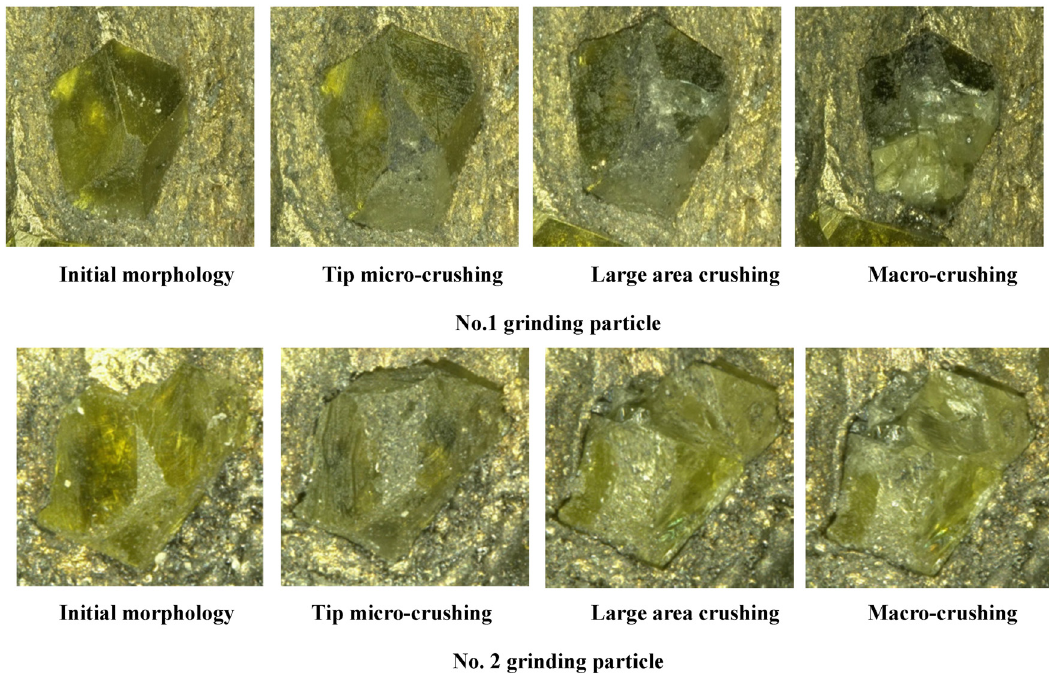
Figure 5: The morphology of the fi rst group of abrasive particles. No. 1 grinding particle and No. 2 grinding particle.